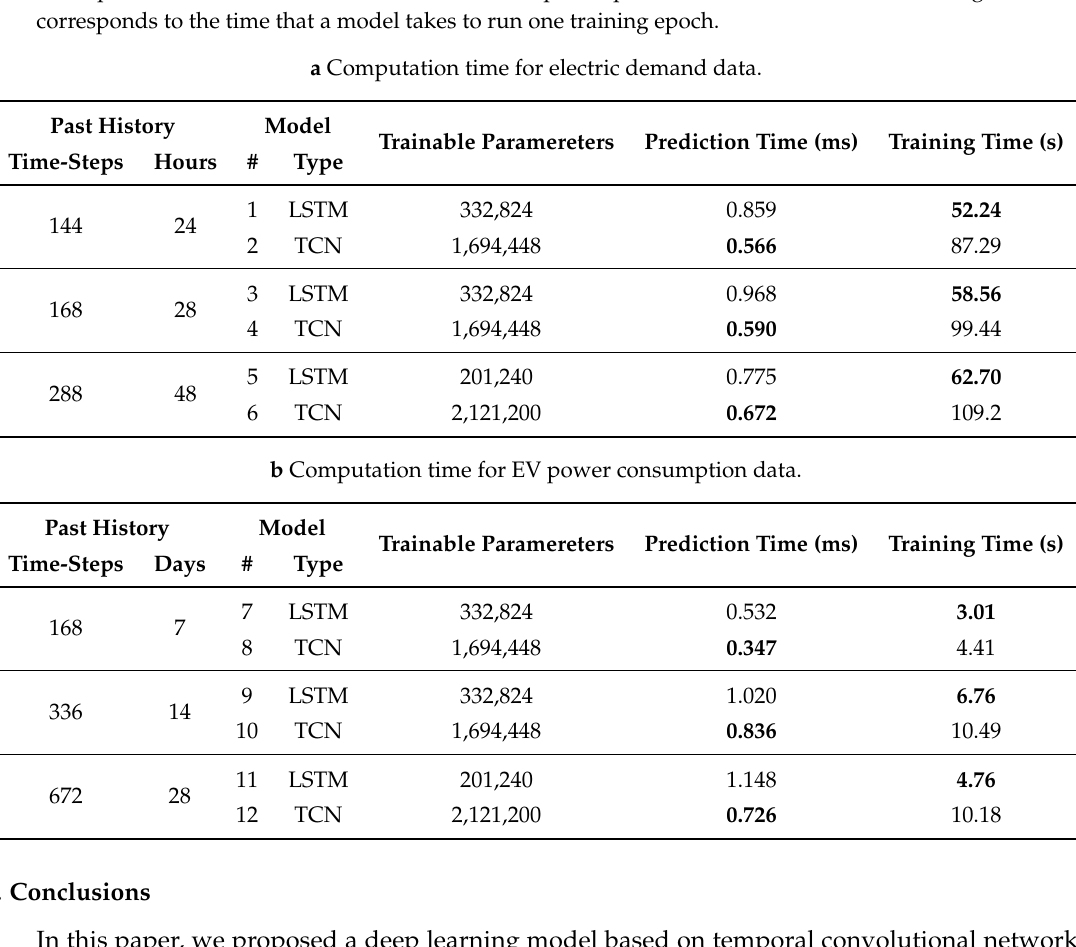
Table 4. Computation time of the best TCN and LSTM models for each dataset. Prediction time corresponds to the time that a model takes to compute a prediction for one instance. Training time corresponds to the time that a model takes to run one training